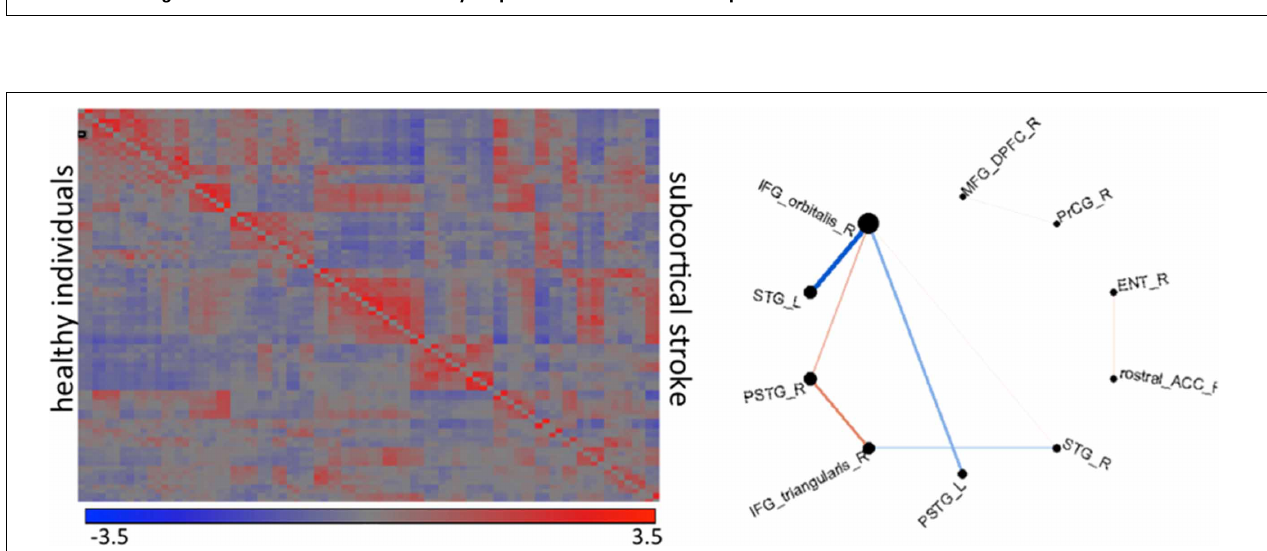
delivering 4 loading vectors for discrimination. The clustering features in the high-dimensional index on the right are shown to correspond to anatomically meaningful shape representation shown in the left panel .